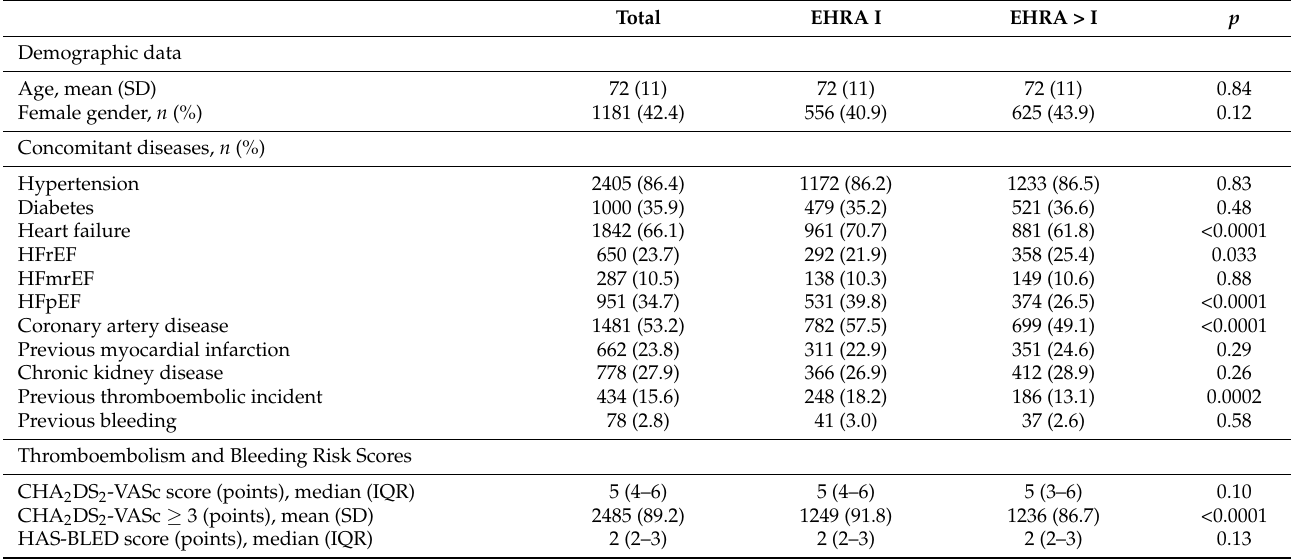
Table 2. Demography and concomitant diseases.